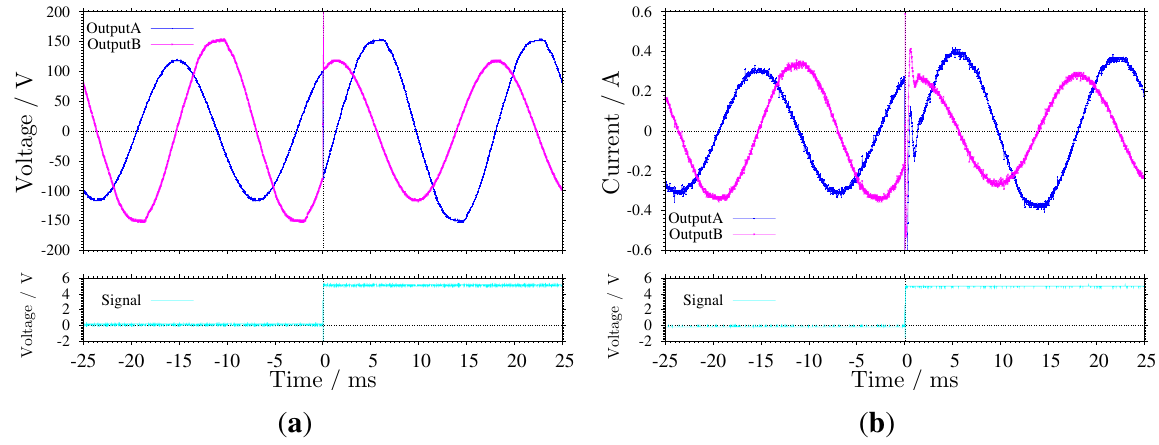
Figure 5. Output waveforms of circuit switching operation with 120 ◦ phase difference between two inputs: ( a ) output voltage waveforms; and ( b ) output current